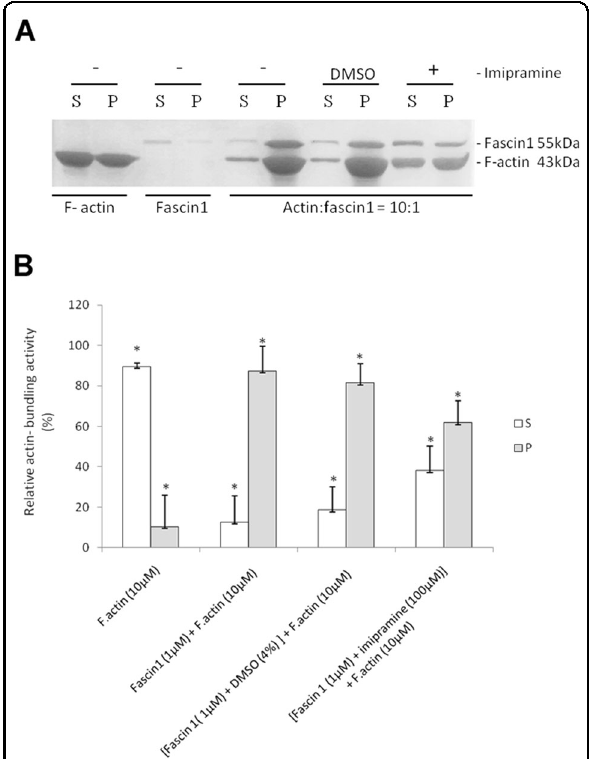
Fig. 3 F-actin bundling activity assay. a Assay of actin-bundling activity with a low-speed cosedimentation assay. Polymerized F-actin (10 µM) was incubated with fascin1 (1 µM) in the presence ( + ) or absence ( − ) of imipramine and DMSO (control). b Quanti fi cation of the F-actin bundling assay from ( a ). The results are the means and SD ( n = 4, * p <